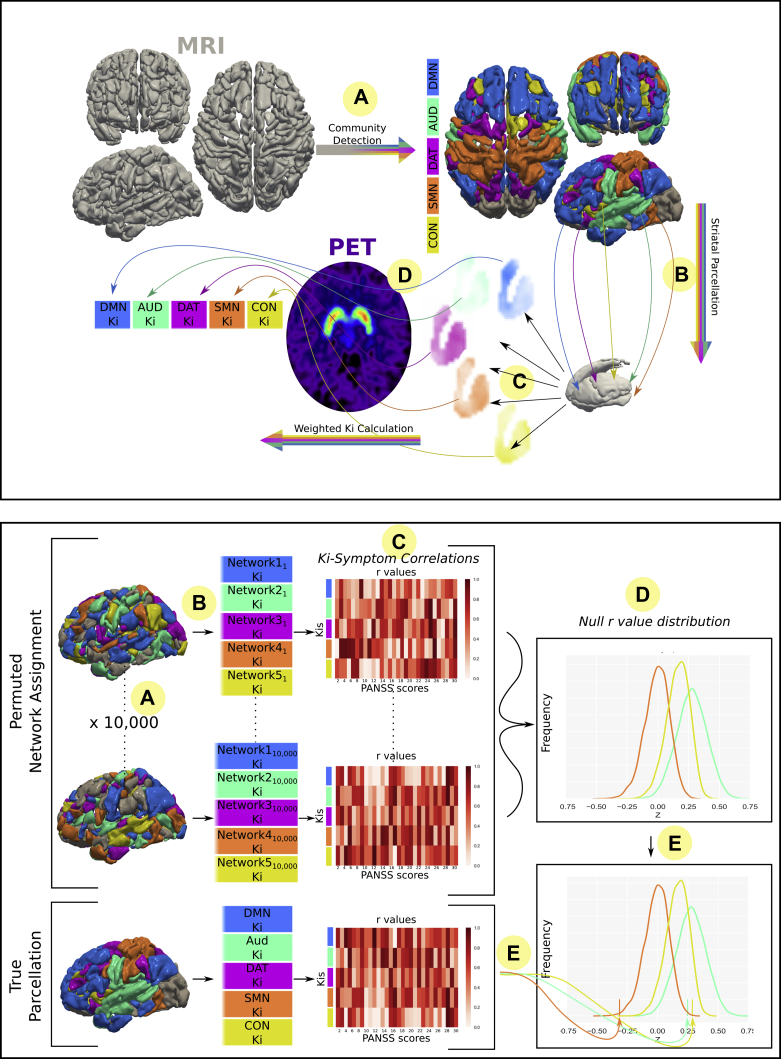
Overview of methods. Top: Participants receive resting-state magnetic resonance imaging (MRI) and 18F-DOPA positron emission tomography (PET) scans. (A) Cortical nodes are assigned to networks based on corticocortical resting-state functional connectivity. (B) Connectivity of each striatal voxel to these cortical networks is calculated. (C) Weighted striatal connectivity maps are produced for each network (see Figure S2). (D) Voxelwise dopamine synthesis capacity (Kicer) (Ki) maps weighted by these striatal connectivity maps to give a Kicer value for each network. Bottom: Significance testing of Kicer-symptom relationships using a permutation testing approach. In addition to permuting at the level of participants (not pictured), cortical regions of interest were permuted to generate null distributions: (A) Cortical regions of interest shuffled into random networks 10,000 times. (B) These shuffled network sets were used to calculate Kicer with the same method described above in the top panel. (C) Symptom-Kicer correlations were calculated for each null set of Kicer. (D) Null distribution was created from repeating step (C) for each of the null network sets. (E) True symptom-Kicer correlation values were compared with null distribution to test statistical significance. AUD, auditory network; CON, cingulo-opercular network; DAT, dorsal attention network; DMN, default mode network; PANSS, Positive and Negative Syndrome Scale; SMN, sensorimotor network.